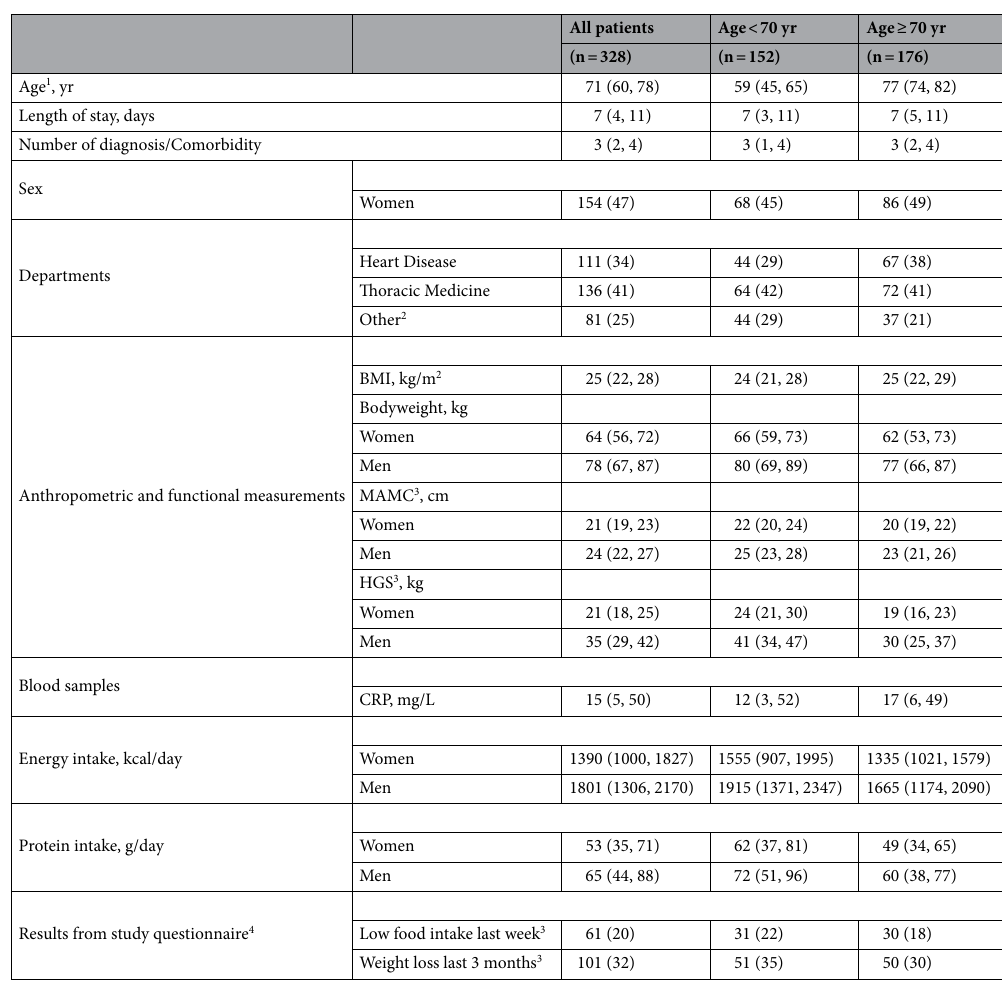
Table 2. Characteristics of patients according to age groups. Continuous variables are presented as medians (25th, 75th percentile) and categorical variables are reported as counts (%). BMI, Body mass index; CRP, C-reactive protein; HGS, handgrip strength; GLIM, Global Leadership Initiative on Malnutrition 1 Age